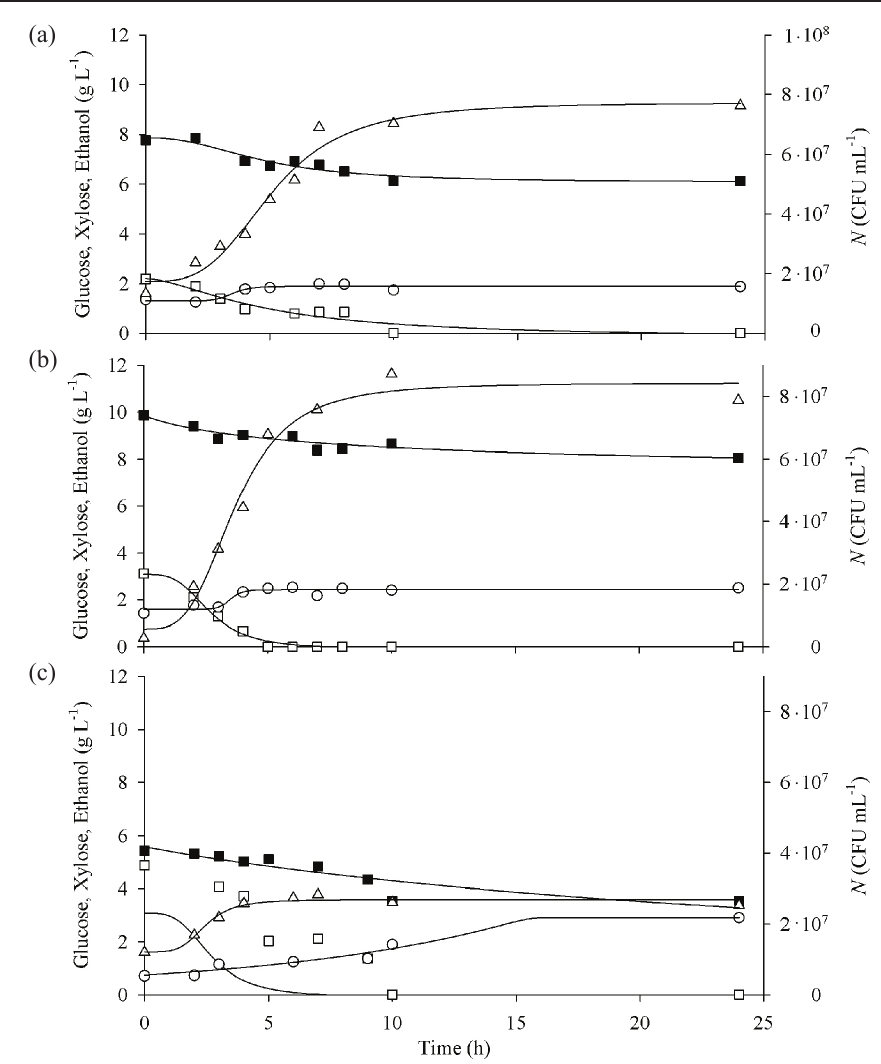
Fig. 5 – Changes in glucose (□), xylose (  ), ethanol (○), and cell number (N, ∆) con - centrations during anaerobic cultivation of genetically engineered S. cerevisiae on different liquor wheat straw hydrolysates: 160 °C/10 min/0.5 % w/w H